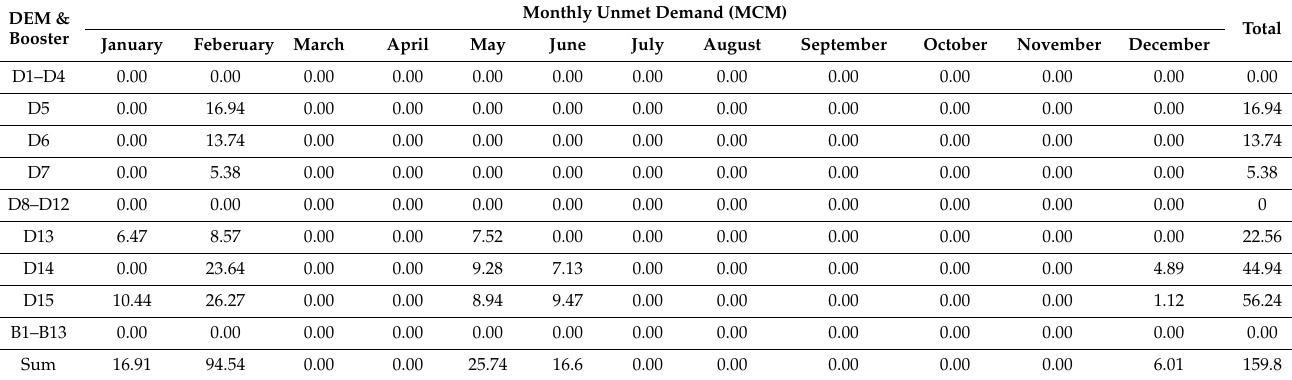
Figure 16. Monthly unmet demands (MCM) resulting from increase in Ismailia Canal head flow by 15%.